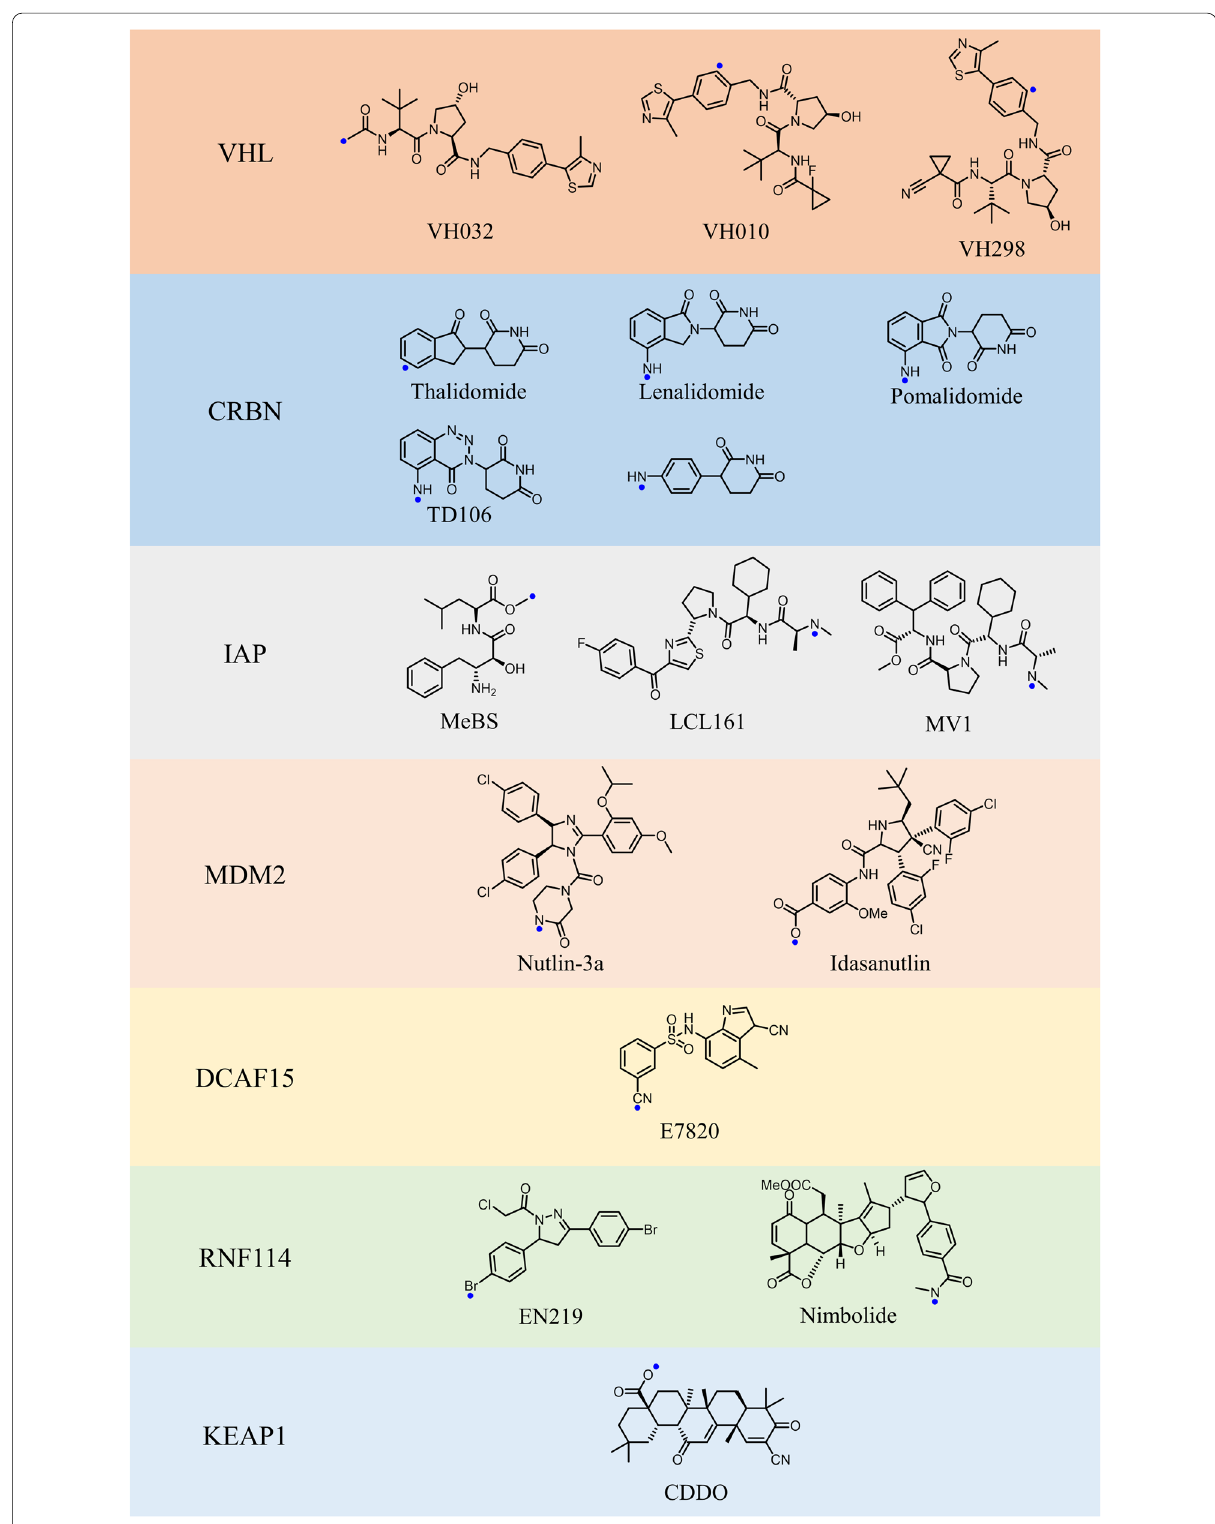
Fig. 3 Representative small molecule ligands of E3 ligases used for PROTACs. Blue dots indicate the appropriate linker attachment